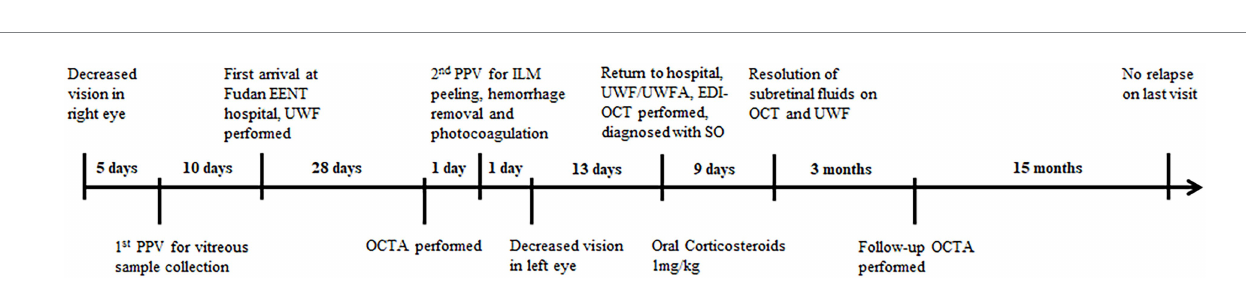
FIGURE 4 Timeline summarizing the progression of SO. The key events or multimodal imaging examination results in the progression of SO are indicated by short lines along the